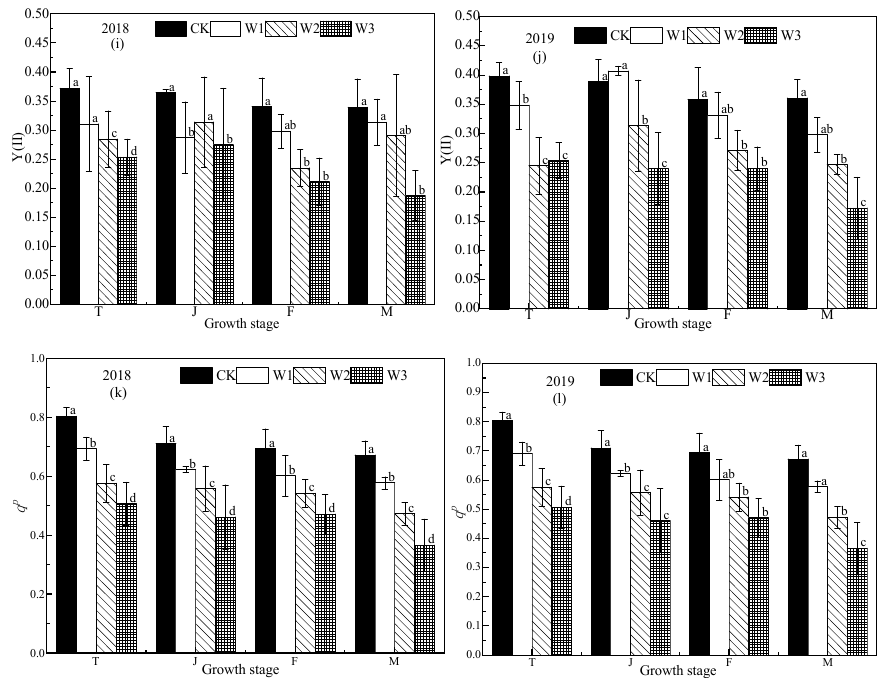
Figure 4. Fluorescence parameters of rice under di ff erent water conditions. The ( a ), ( c ), ( e ), ( g ), ( i ), and ( k ) represent the F 0 , F v /F m , ETR, NPQ, Y(II), and q p , respectively, in 2018. ( b ), ( d ), ( f ), ( h ), ( j ), and ( l ) represent the F 0 , F v /F m , ETR, NPQ, Y(II), and q p , respectively, in 2019. T, J, F, and M represent the tillering, jointing, grouting, and mature stages, respectively. CK: flooding treatment, W1: Irrigation limit 0.85–1.00 θ s, W2: Irrigation limit 0.75–1.00 θ s, and W3: Irrigation limit 0.65–1.00 θ s. The data are the mean ± the standard error. Di ff erent letters indicate significant di ff erences between treatments ( p < 0.05). Table 4. Correlation matrix between chlorophyll fluorescence parameters and photosynthesis of drip irrigated rice where * indicates significance at p < 0.05 and ** indicates significance at p < 0.01, sample size (N = 24). maximum fluorescence yield ( F m ), initial leaf fluorescence yield ( F 0 ), fluorescence yield ( F’ ), maximum fluorescence yield ( F’ m ) was measured under light adaptation; the maximum photochemical efficiency ( F v /F m ), PSII potential activity ( F v /F 0 ), Conversion efficiency of PS Ⅱ open reaction center( F’ v /F’ m ), photochemical quenching coefficient ( q p ), non-photochemical quenching